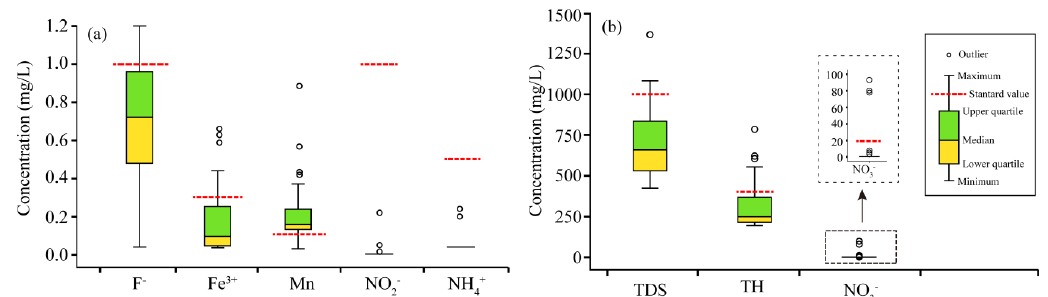
Figure 2. Box plots with respect to the reference Chinese national standards values for the selective chemical parameters (in mg/L) of the groundwater. ( a ) concentrations of relatively low-content chemical constituents; ( b ) concentrations of relatively high-content chemical constituents.